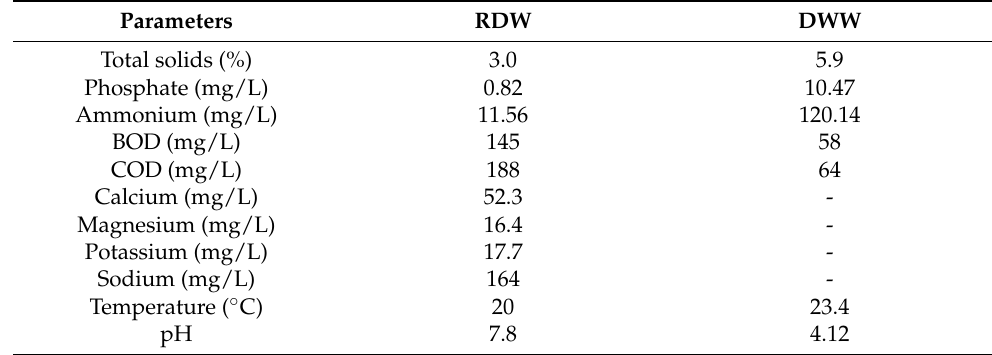
Table 2. Physicochemical parameters of the domestic wastewater used in the batch experiments.